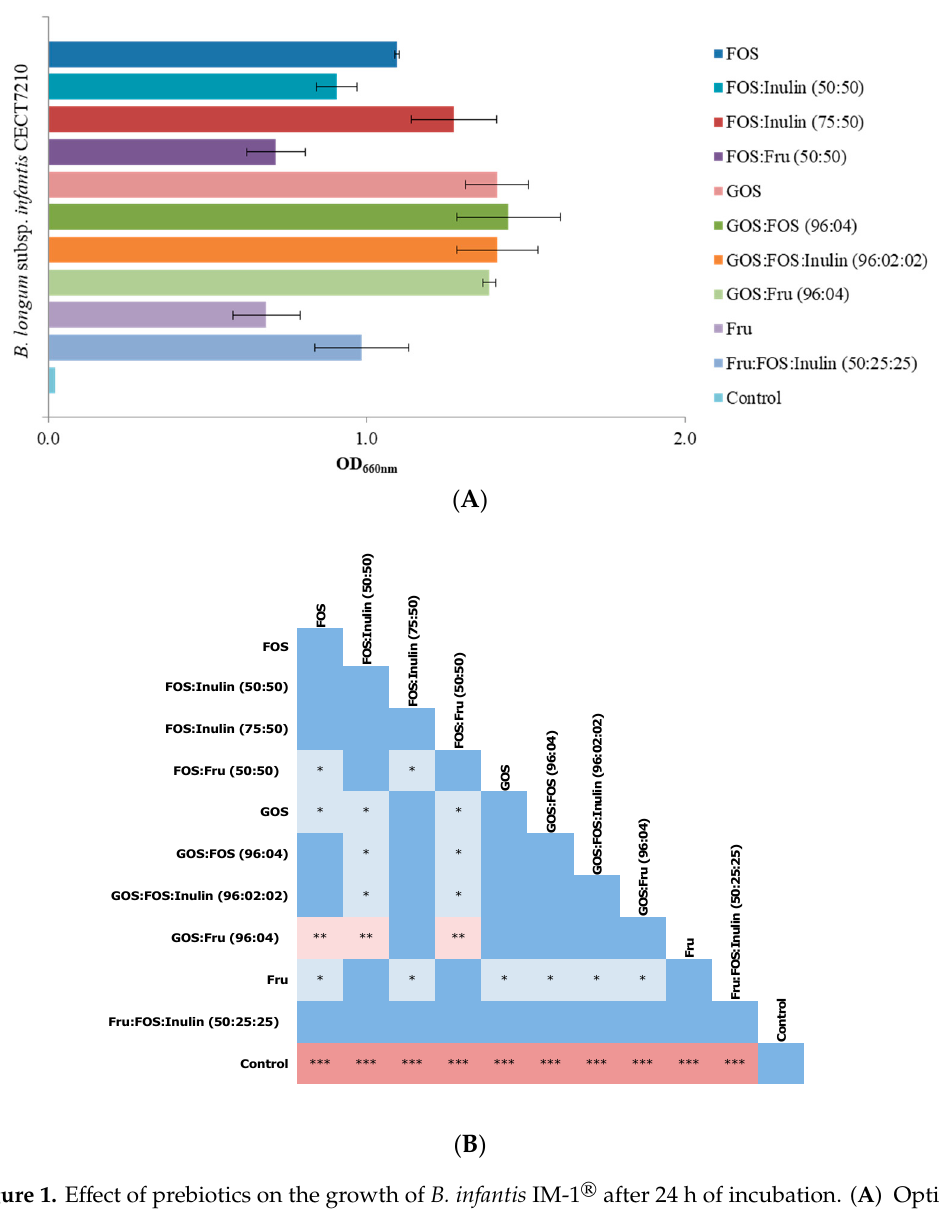
(0.8% final concentration). After 24 h, the growth of pathogens and B. infantis IM-1 ® was determined